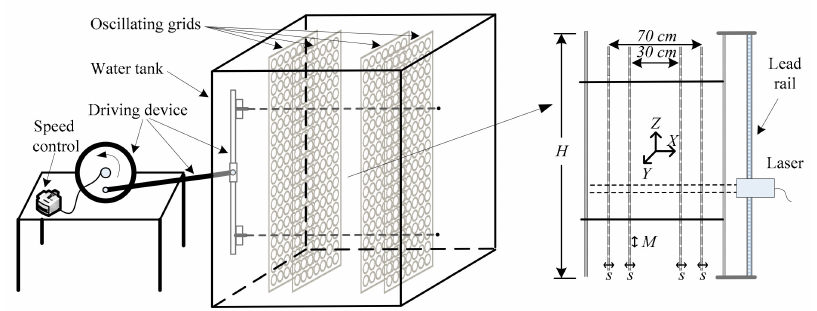
Figure 1. Sketch map of the experimental